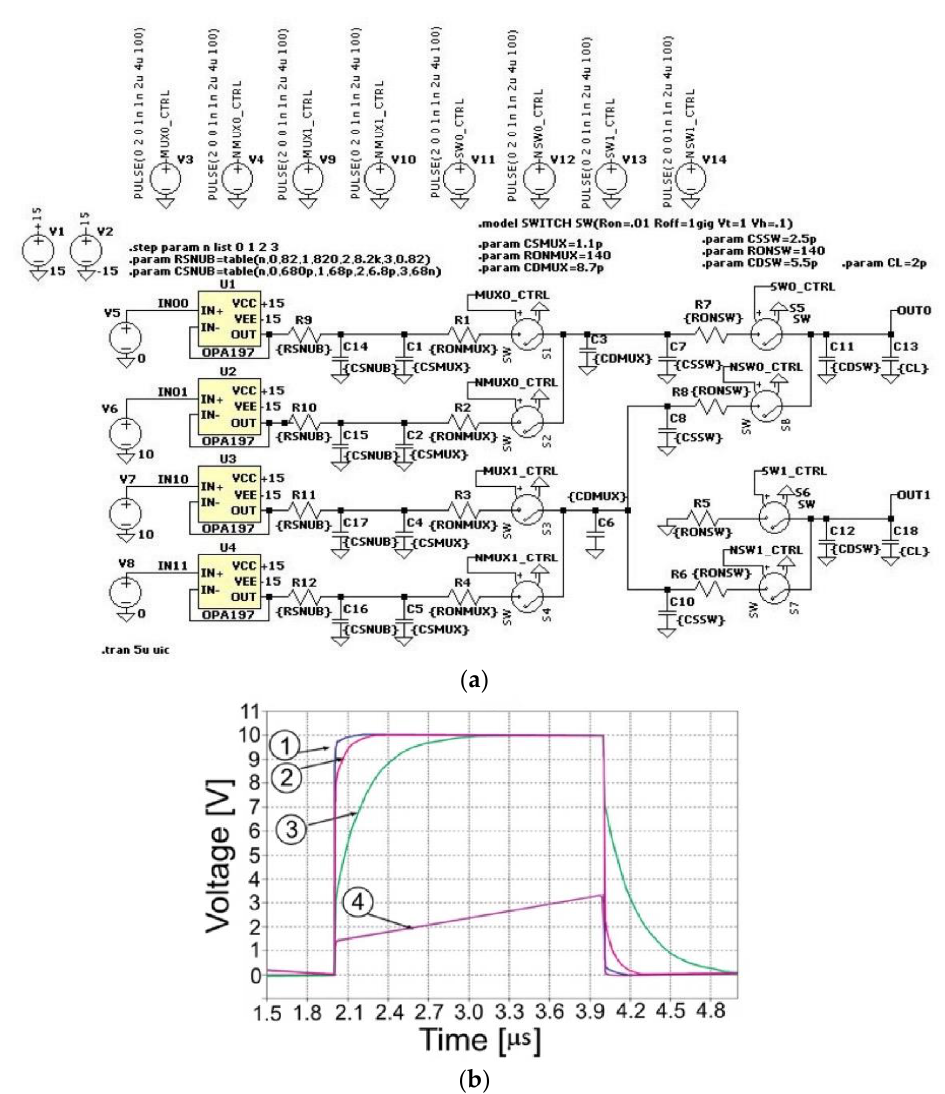
Figure 6. Scheme of the simulation of the settling time of the multiplexer and switch considering the input buffers ( a ). Results of the simulation of the settling time of the multiplexer and switch considering the input buffer ( b ).